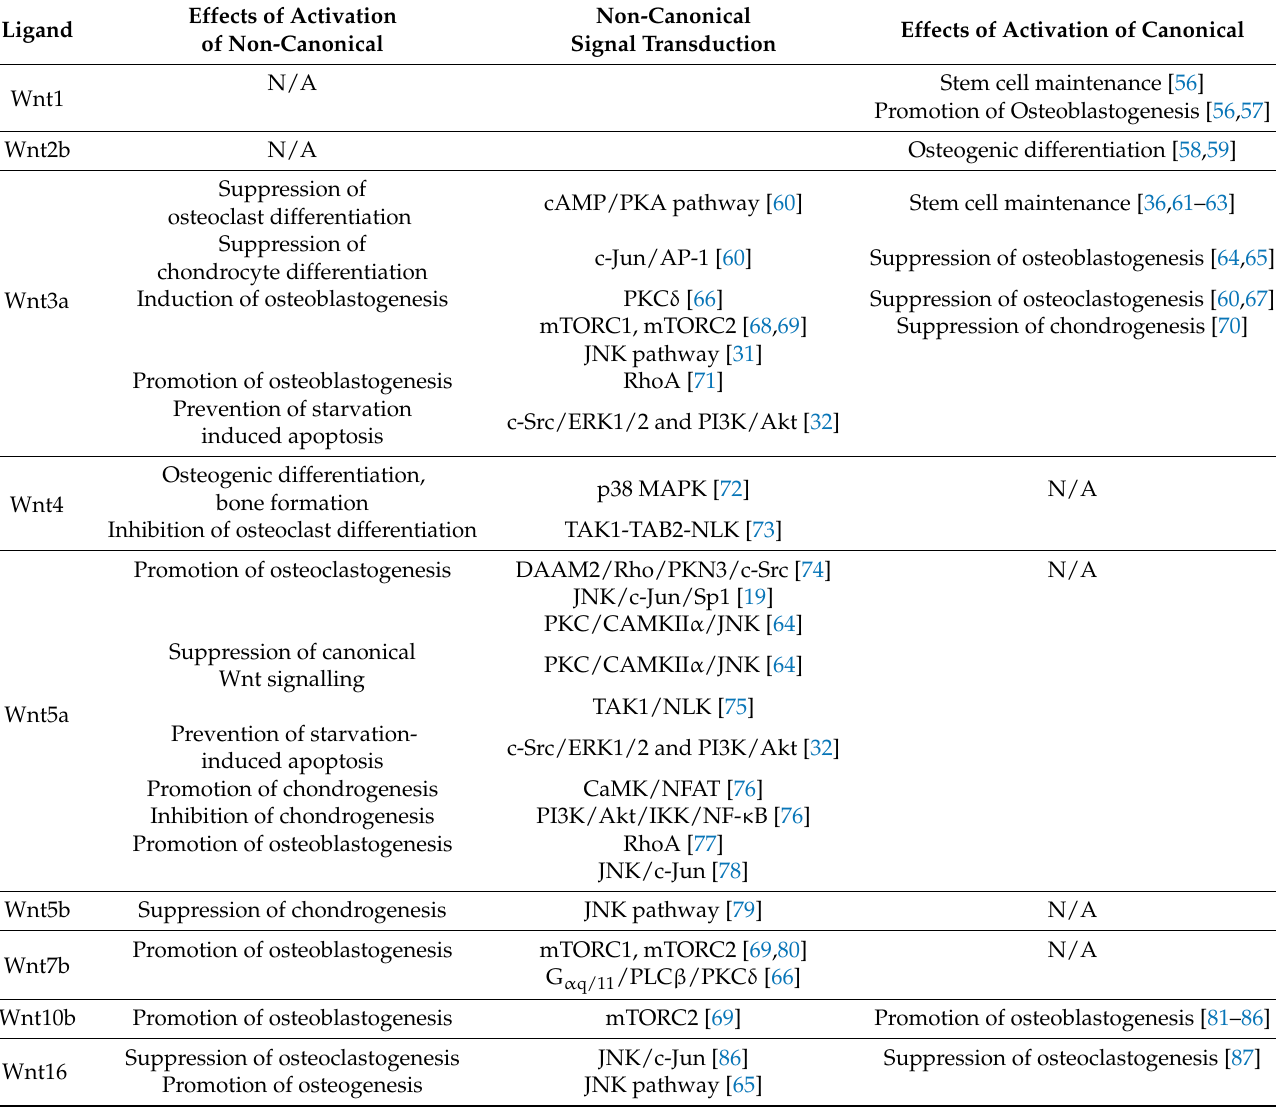
Table 1. The effect of activation of the canonical and non-canonical signalling pathways with prominent roles in bone homeostasis. Only studies where the involved signalling pathway was confirmed are